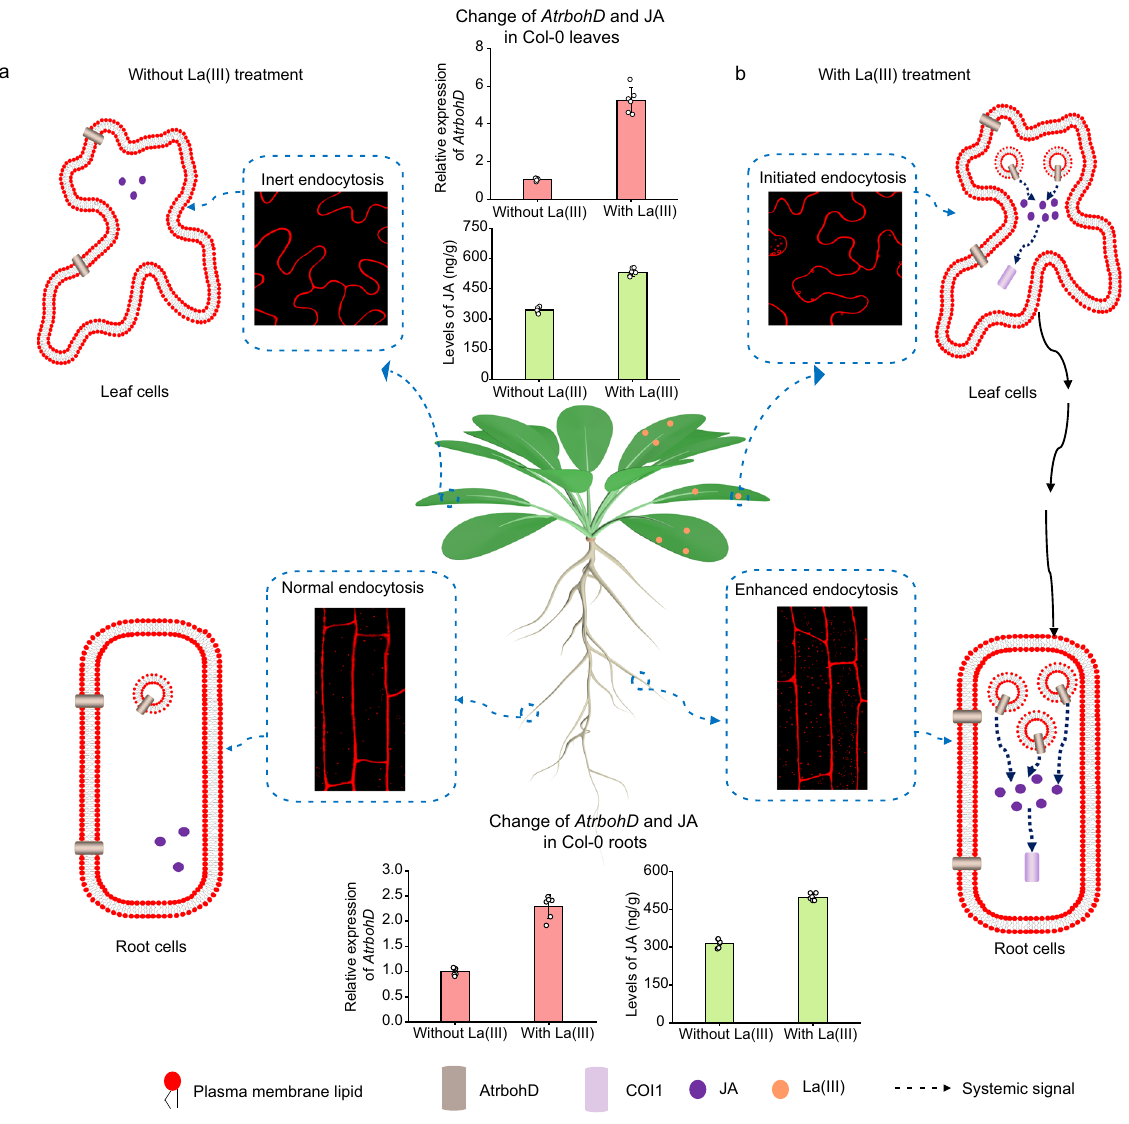
Fig. 5 A model for AtrbohD- and JA-dependent systemic endocytosis induced by La(III). a Without La(III) treatment, inert endocytosis and normal endocytosis were maintained in leaf and root cells, respectively. Meanwhile, small amounts of JA were produced in leaf and root cells. b La(III) treatment on leaves induced CME in leaf cells. AtrbohD promoted the accumulation of JA, and JA further transmitted systemic endocytic signal with the participation of COI1-dependent signaling. This systemic signal induced the enhanced CME in root